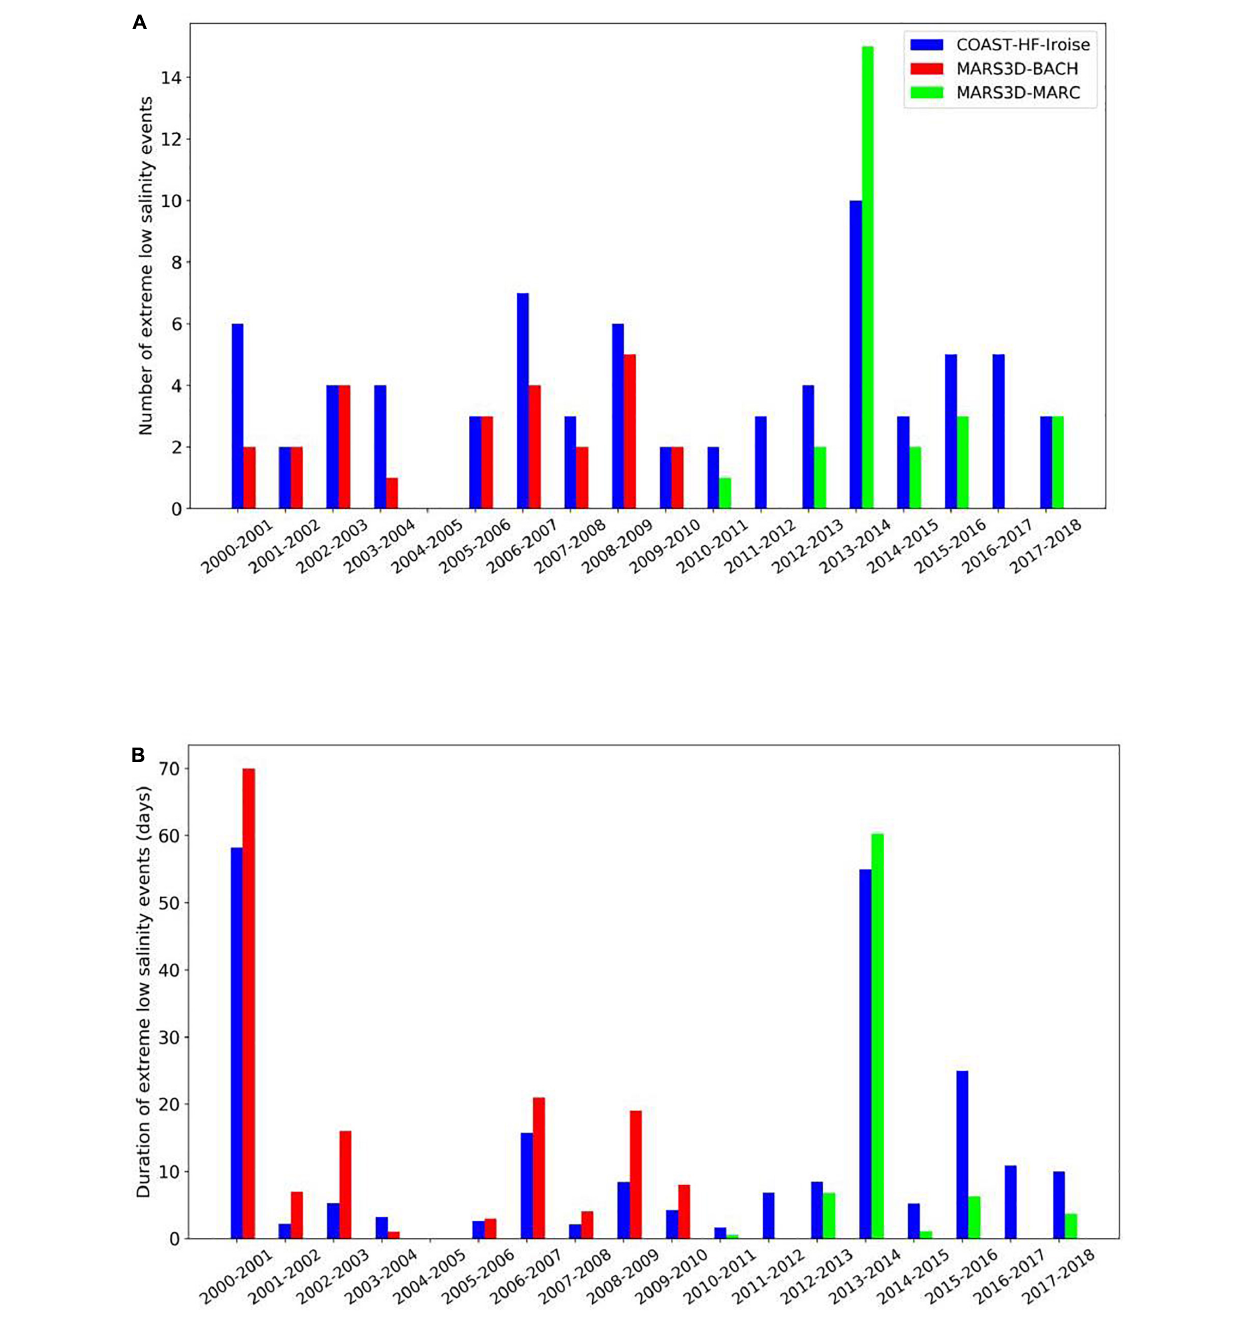
FIGURE 5 | Histograms of (A) the number and (B) duration (in days) of extreme low salinity events concomitant in time with observed (COAST-HF-Iroise buoy, in blue) and simulated (MARS3D–BACH model and MARS3D–MARC, in red and green, respectively) data during the 2000–2018 period.